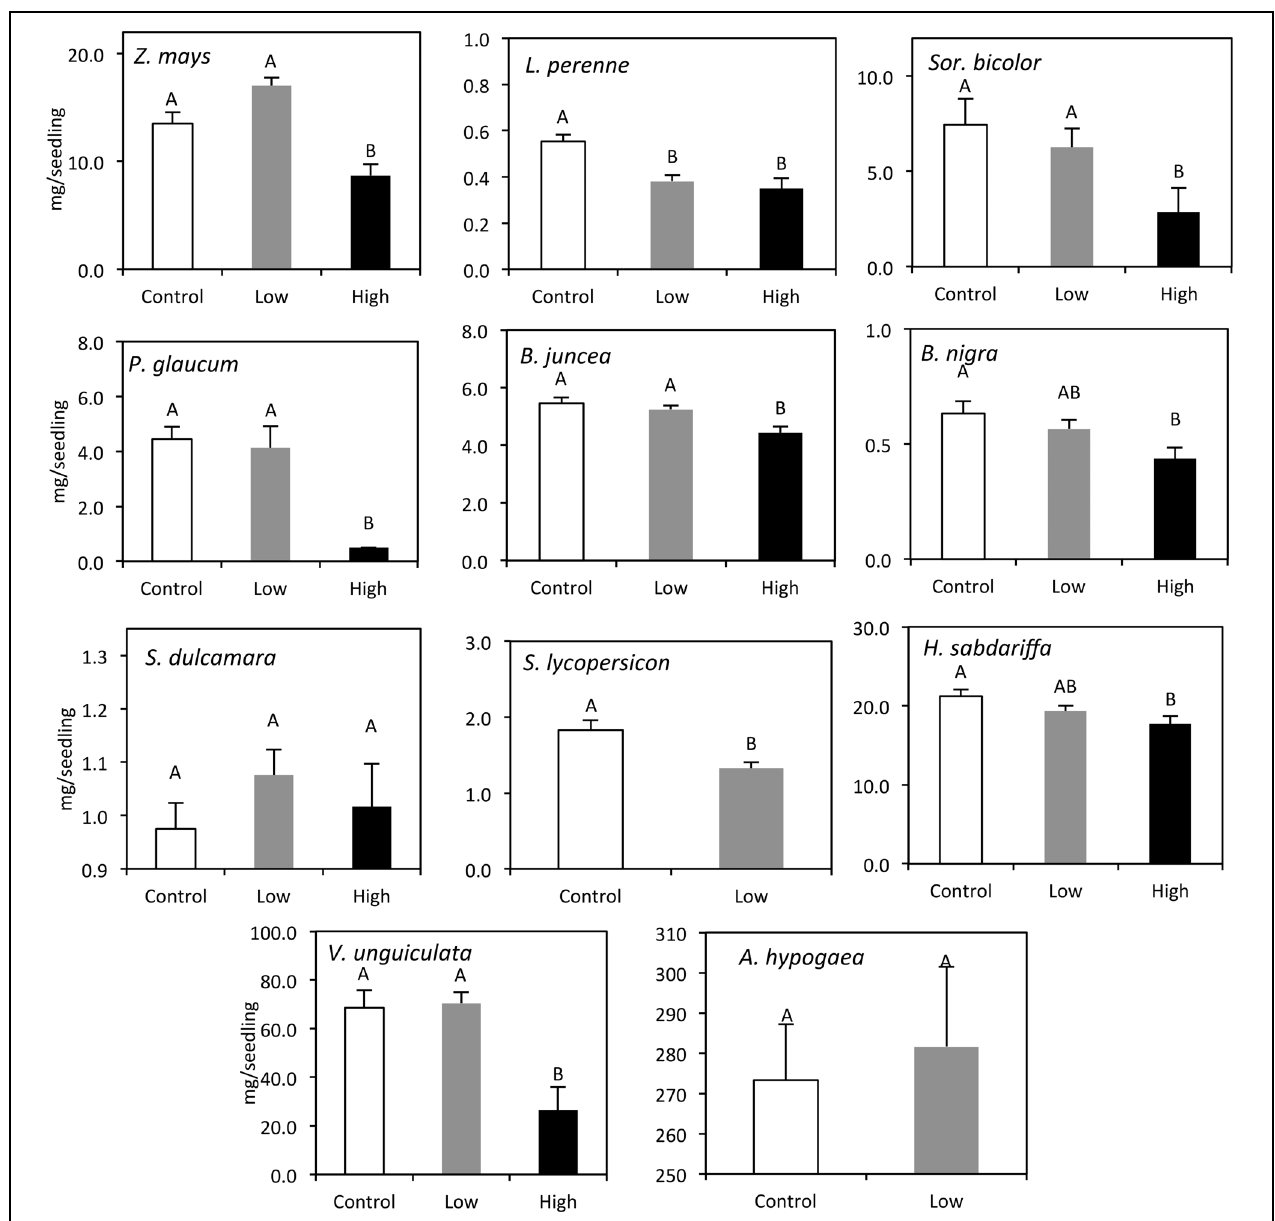
FIGURE 4 | Dry mass of seedlings ( + SEM) after 14 days in each treatment group: Control (white open bars), Low (gray bars), and High (black bars). Different letters represent statistically significant differences in dry weight (Tukey mean separation, p < 0.05).